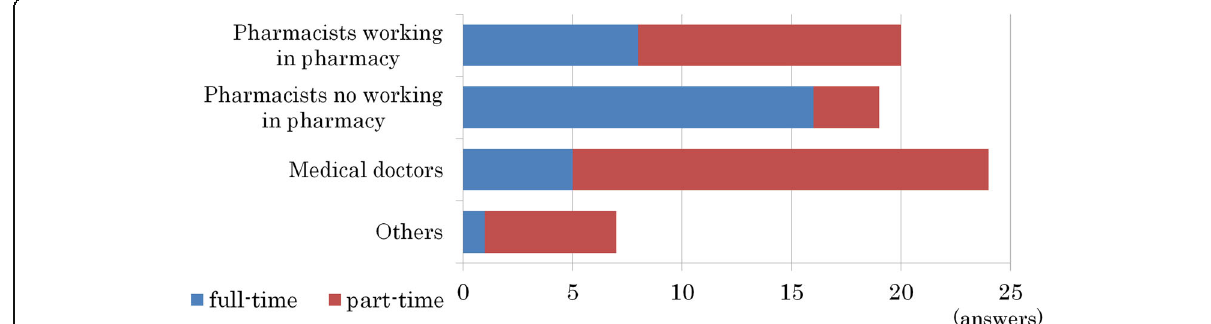
Fig. 3 Teachers ’ qualifications, of those who taught clinical-based medicine in the pharmacy schools answered by 49 schools (66%). These classes were mostly taught by pharmacists employed in pharmacies and physicians. Thirty-one schools (63%) recruited part-time teachers from among pharmacists employed in pharmacies and physicians. Physicians were recruited in 24 schools